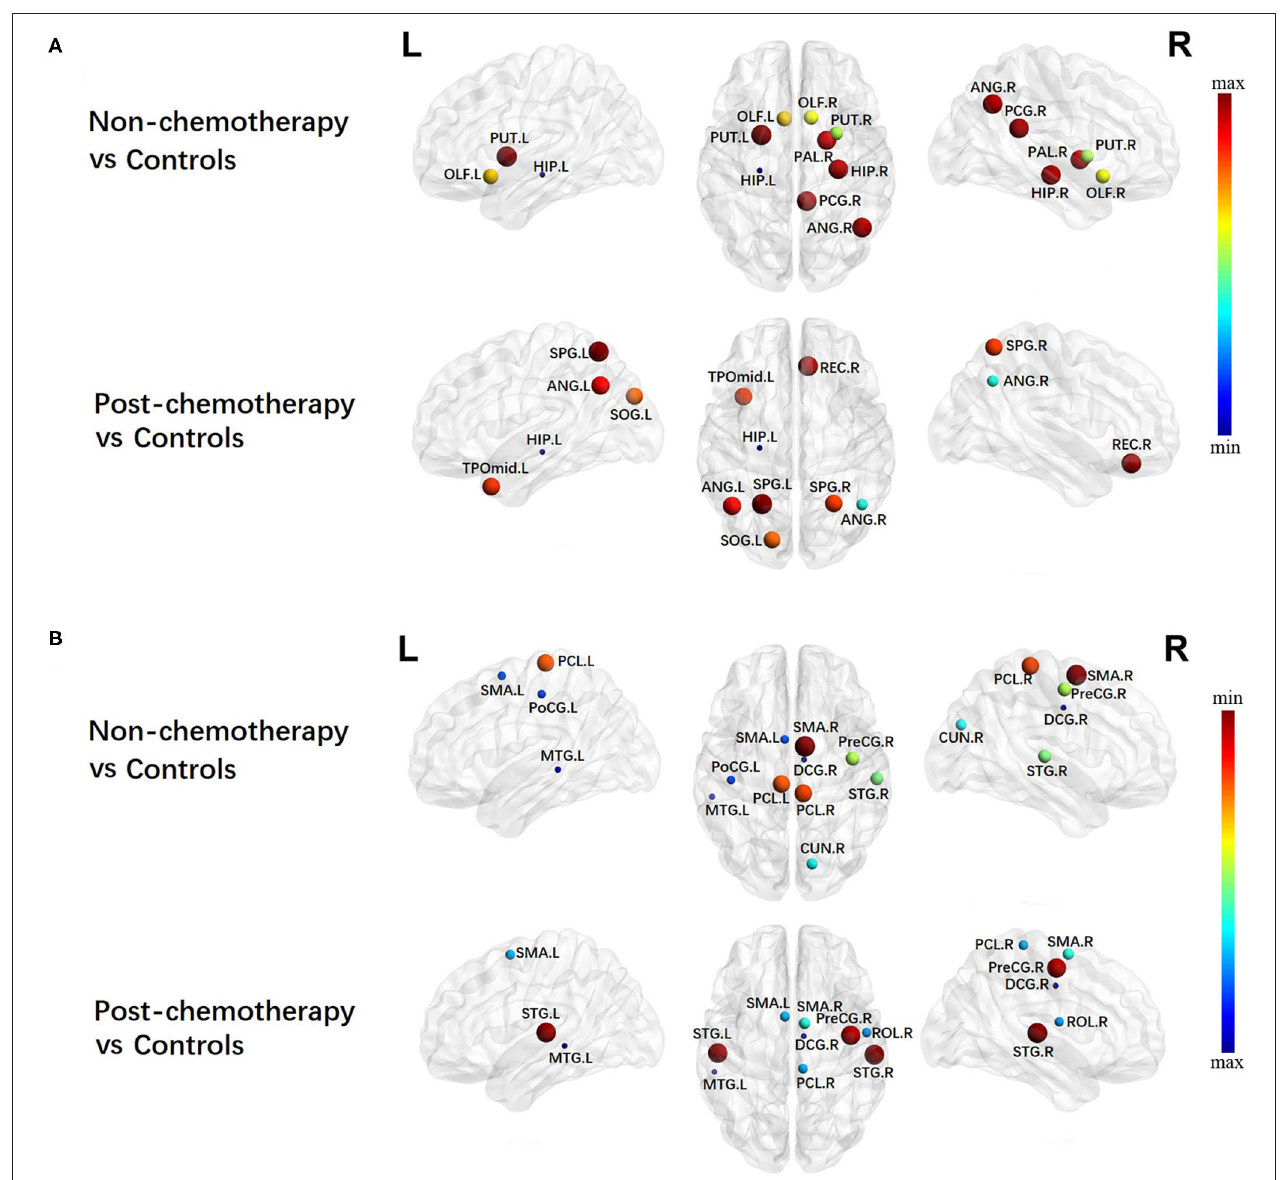
FIGURE 4 | Regions showing increased (A) and decreased (B) degree centrality in non-chemotherapy compared with healthy controls and post-chemotherapy compared with healthy controls. Correction for multiple comparisons was performed using the Bonferroni calibration ( P Bonferroni < 0.05). The size of the nodes represents the T value, and the color of the nodes represents the P Bonferroni value. (A) The bluer the color of the node was, the smaller the P Bonferroni was, and the redder the color of the node was, the larger the P Bonferroni was. (B) The redder the color of the node was, the smaller the P Bonferroni was, and the bluer the color of the node was, the larger the P Bonferroni was . The nodes were mapped onto the cortical surfaces using the BrainNet Viewer package